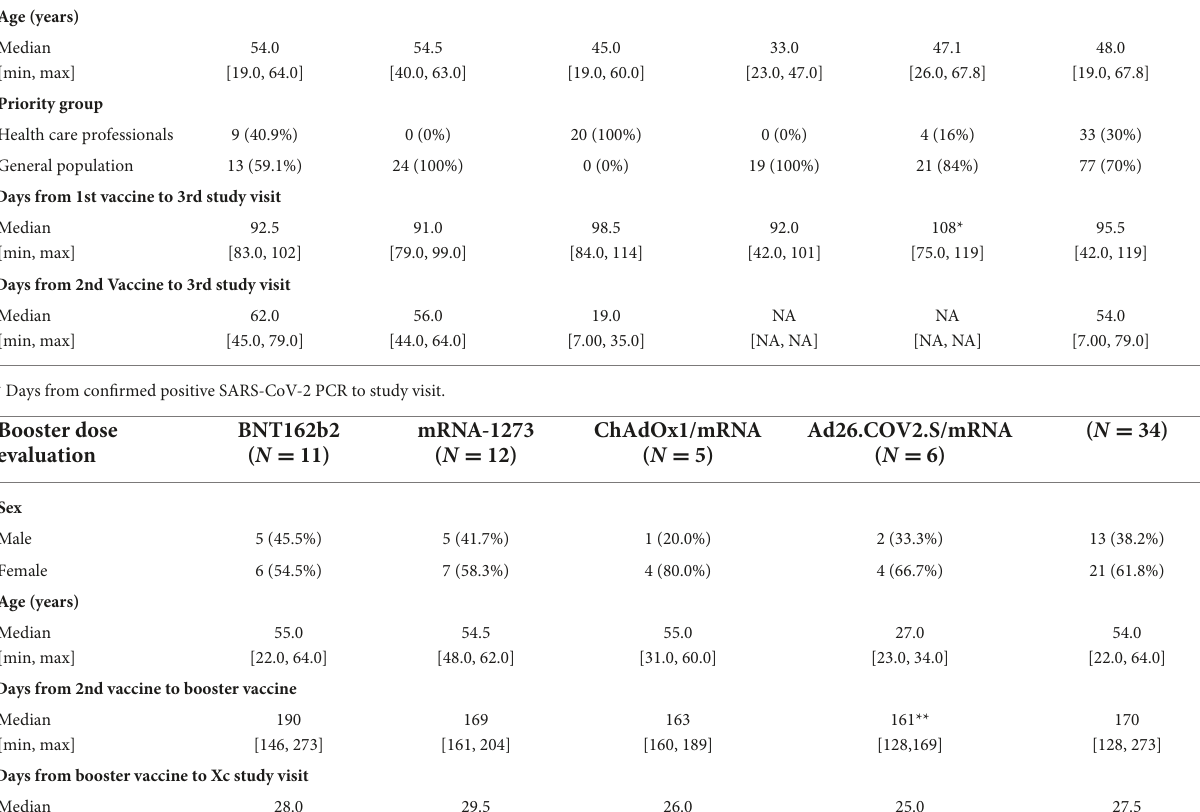
ACE2 receptor-blocking antibodies ( ρ = 0.88, P -value < 0.0001, Figure 3C ) and for the percentage of ACE2 receptor blocking ( ρ = 0.87, P -value < 0.0001, Figure 3D ). This strong positive correlation between pseudovirus